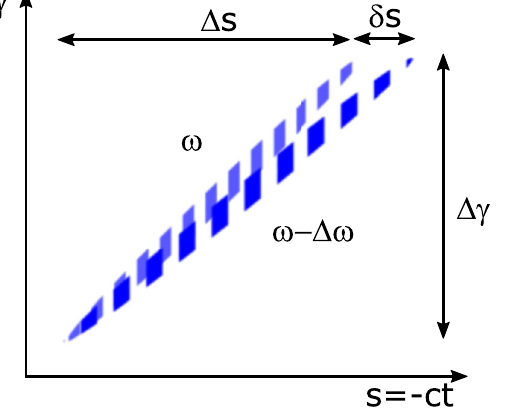
FIG. 6. Illustration of the longitudinal phase space of a linearly chirped electron beam with coherent density modulation at frequency ω . This frequency is shifted by Δ ω upon propagation through an element with non-zero compaction